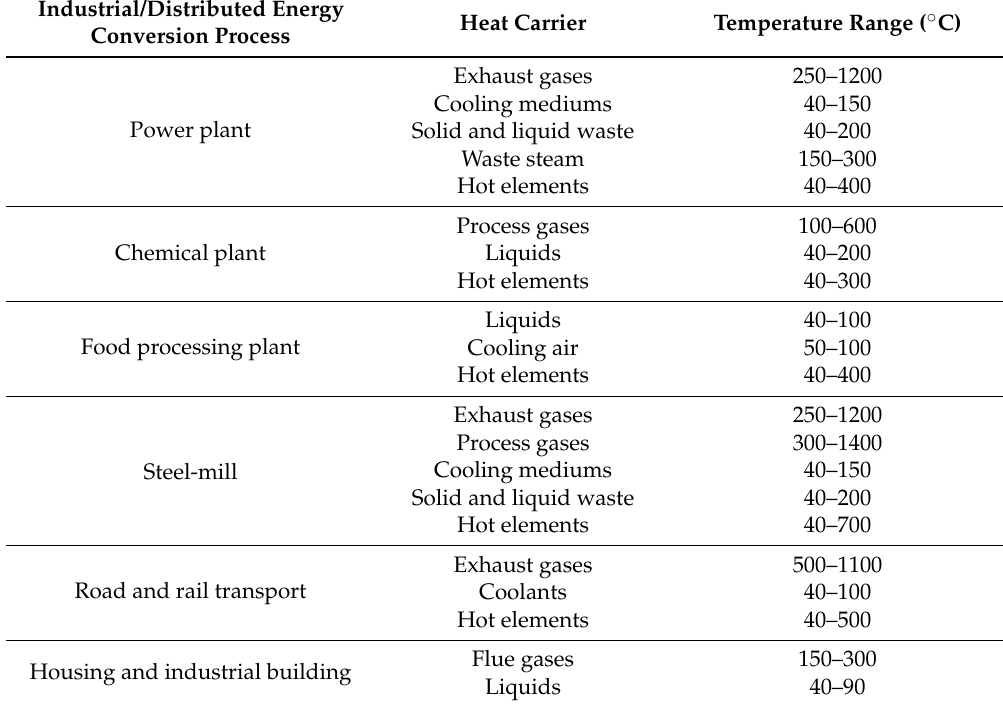
Table 1. The temperature ranges of the selected waste heat sources